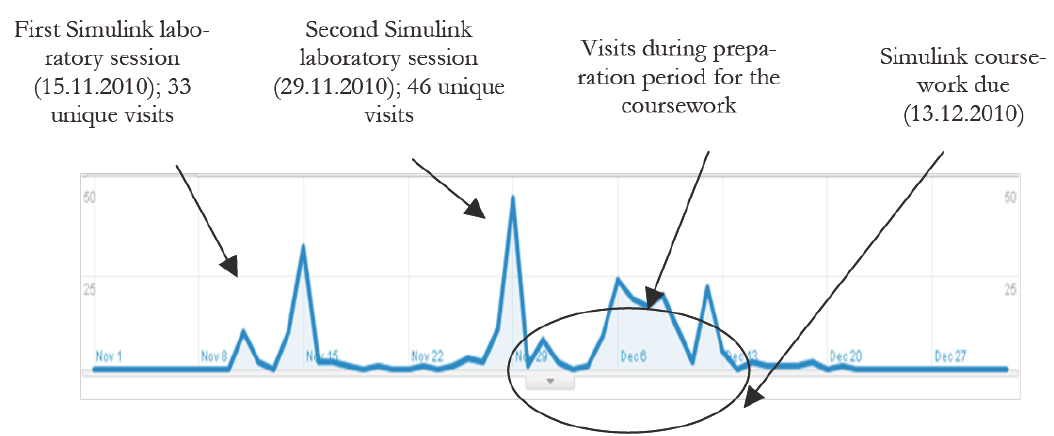
Figure 1. Google analytics of the unique visits of the websiteof the Simulink videao